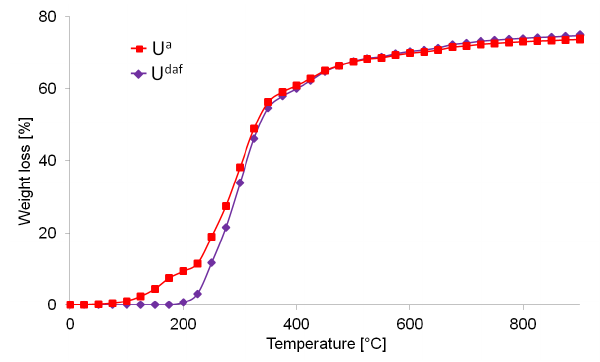
Figure 2: Thermogravimetric analysis of giant knotweed pellets in analytical state (U a ) and dry ash-free state (U daf